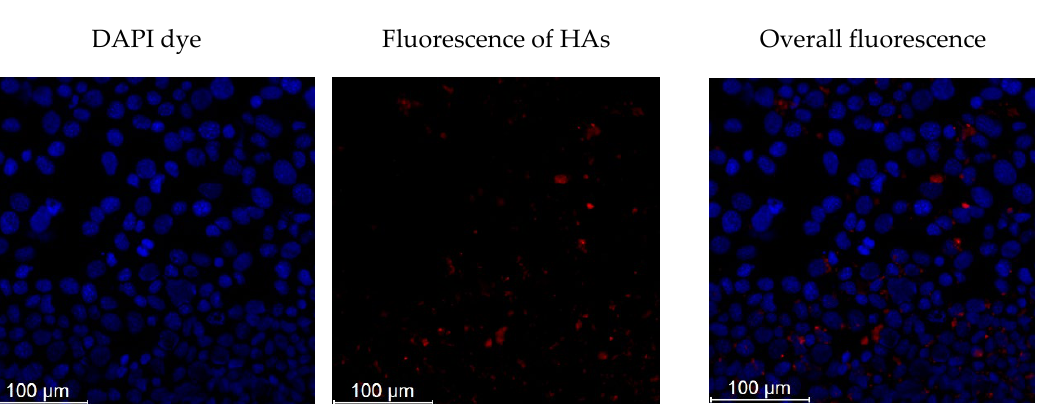
Figure 4. Viability of 3T3-L1 normal fibroblast cells incubated with HAs. Taking into account the experimental data on antioxidant and cell protective activity of HAs, these effects could be attributed to three factors: 1.